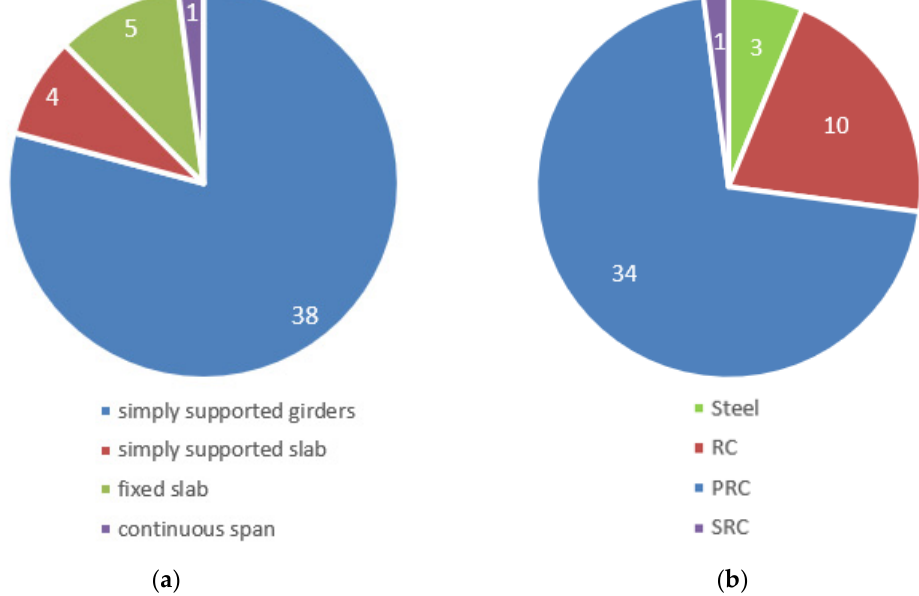
Figure 4. Distribution of bridges by static scheme ( a ) and deck material ( b ) (RC = reinforced concrete; PRC = prestressed reinforced concrete; SRC = steel reinforced concrete).